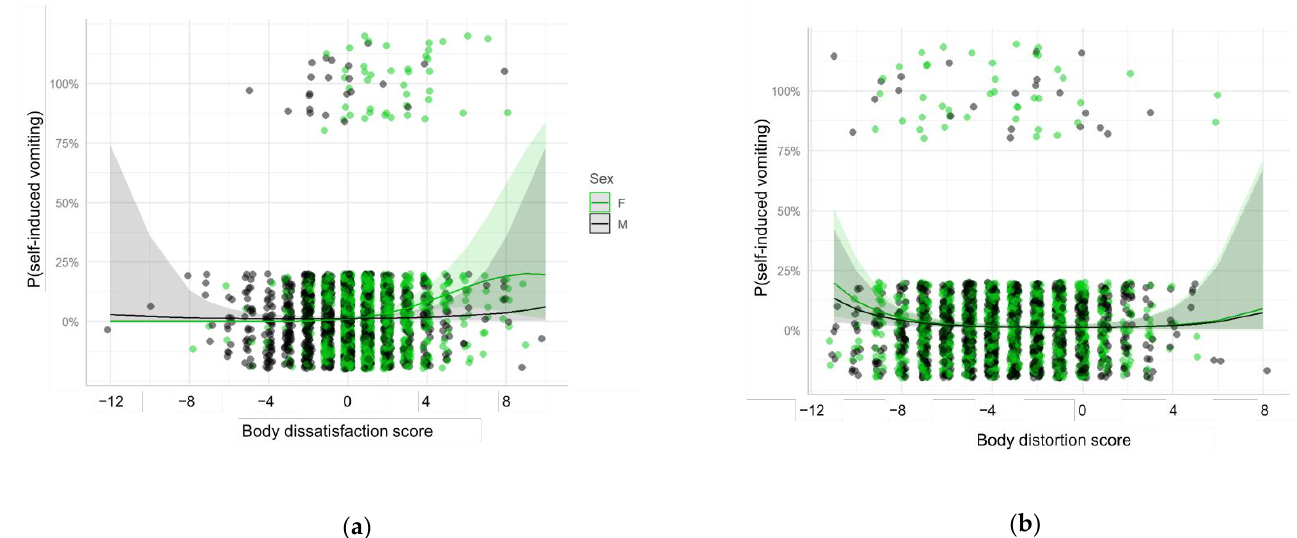
Figure 3. Random-intercept mixed effects logistic regression model for the presence of self-induced vomiting as a function of ( a ) Body dissatisfaction score; ( b ) Body distortion score; and their interaction with sex. Each point represents a participant, the lines represent the fitted model and the shades represent the 95% confidence interval. The points are slightly jittered in order to avoid overplotting. F: Female; M: